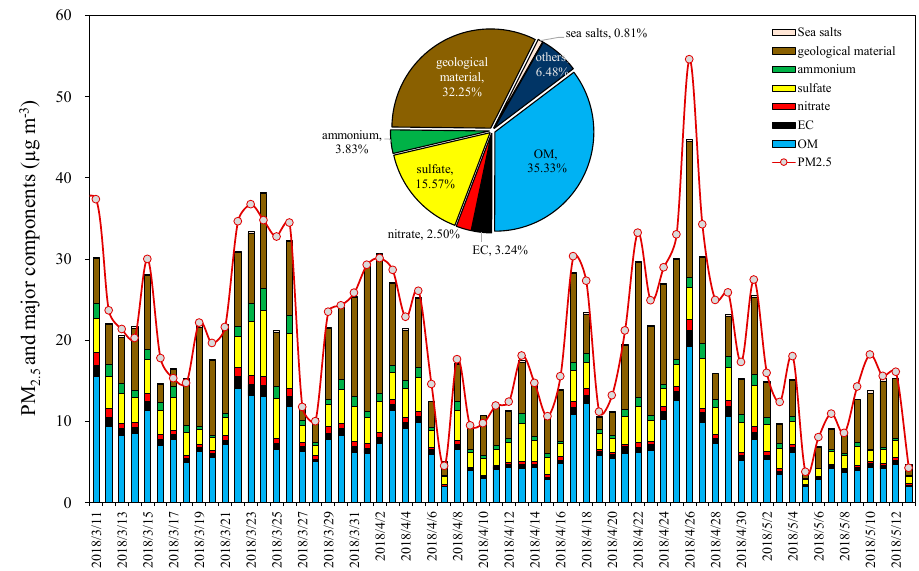
Figure 2. Daily variations in composition of PM 2.5 at the sampling site. Pie chart is the averaged PM 2.5 material balance between 11 March and 13 May